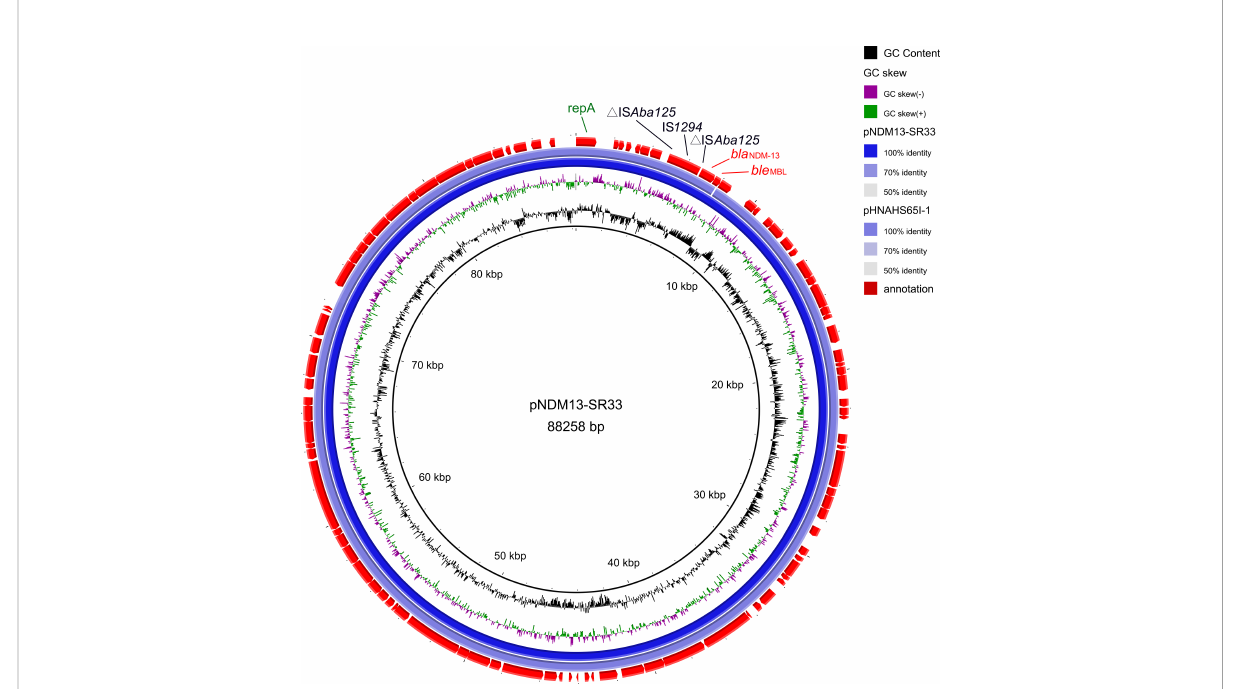
FIGURE 2 Genetic map of pNDM13-SR33 (no. CP092912) and pHNAHS65I-1 (no. MN219406). The repA, IS elements, resistance genes are annotated by green, black, red fonts, respectively.